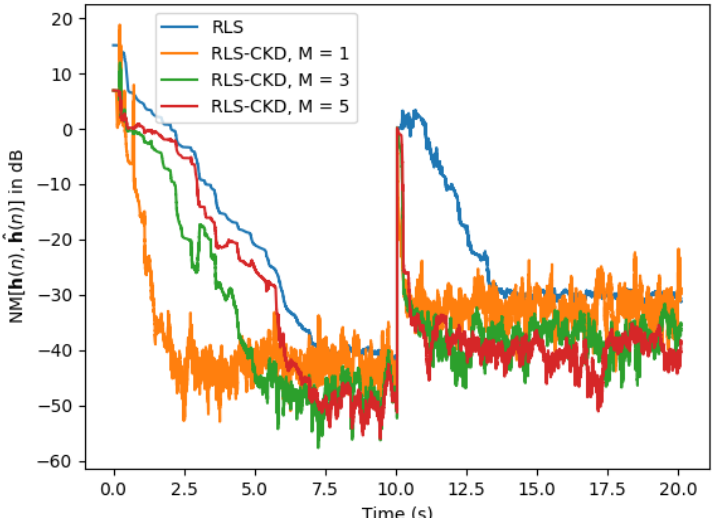
Figure 9. Normalized misalignment of the classical RLS ( L = 512) and RLS-CKD ( L 1 = 64, L 2 = 8) algorithms. The input signal is a speech sequence and the impulse response changes in the middle of the